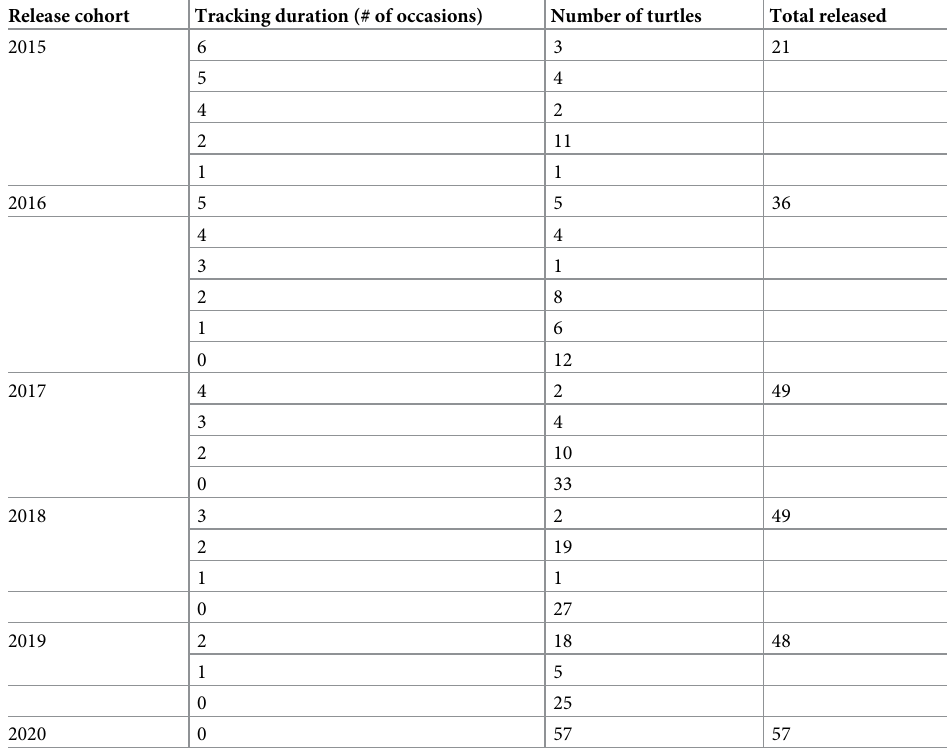
Table 1. Number of headstarted Blanding’s Turtles included in the Jolly-Seber open population model. Head- started turtles were grouped based on release year (release cohort) and further subdivided based on number of years tracked, which resulted in 23